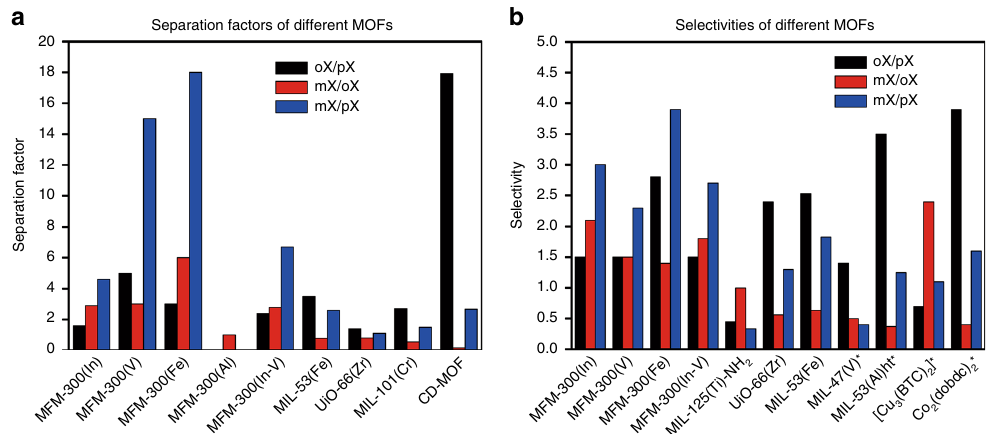
Fig. 4 Comparison of separation performance in various MOFs. a Comparison of separation factors calculated from chromatographic experiments; b comparison of selectivity data calculated from breakthrough curves. The separation factors were calculated based on pulse chromatograms using Eq. (1) in the method section and selectivities were calculated from the ternary breakthrough curves (Eqs. (3) and (4)). Selectivities denoted by an asterisk were calculated from multicomponent liquid-phase adsorption experiments. Details of conditions reported in literature examples are shown in Supplementary Table